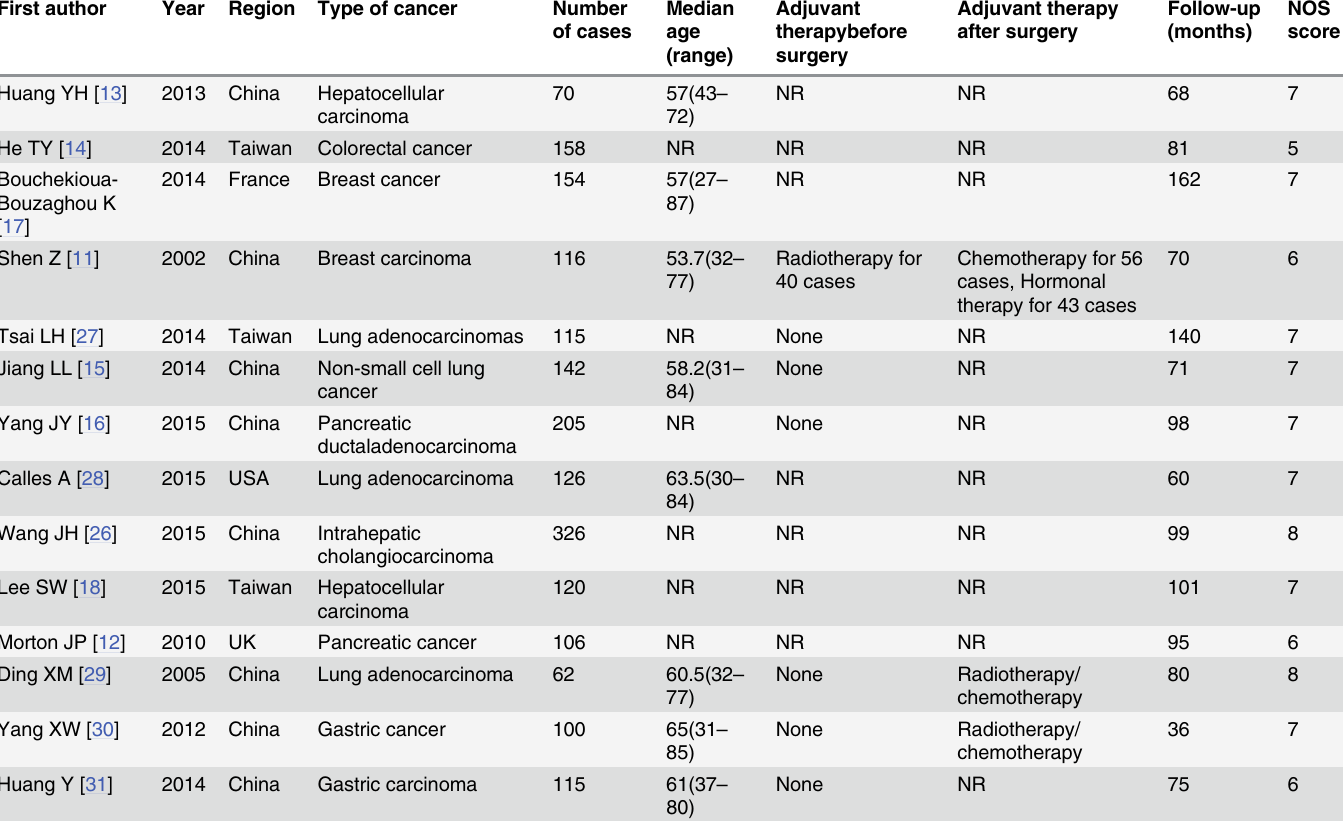
Table 1. Main characteristics of the eligible